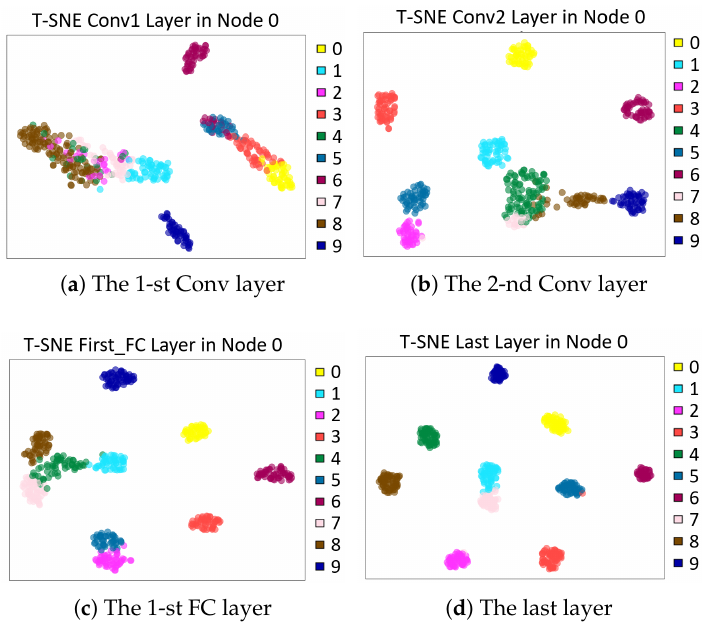
Figure 12. T-distributed stochastic neighbor embedding visualization of the convolutional neural network features and layers in Node 0.